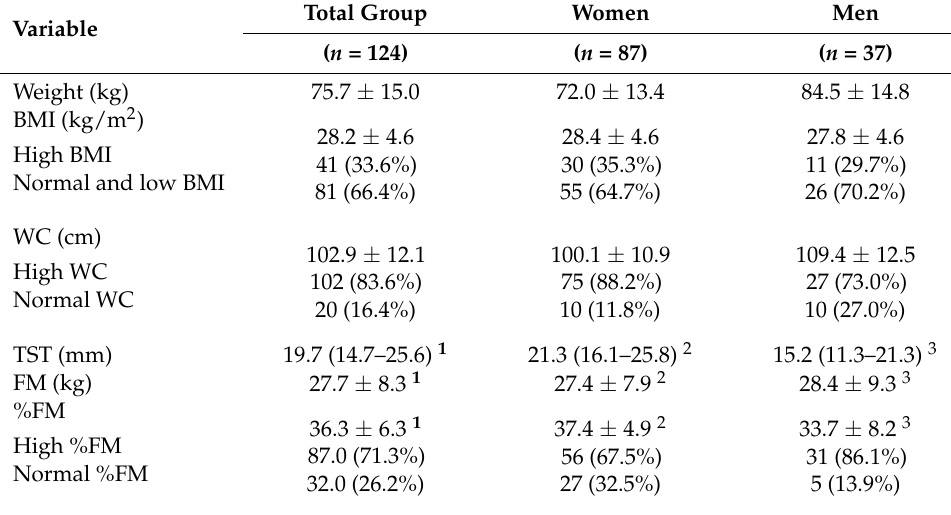
Table 2. Obesity of geriatric rehabilitation patients at